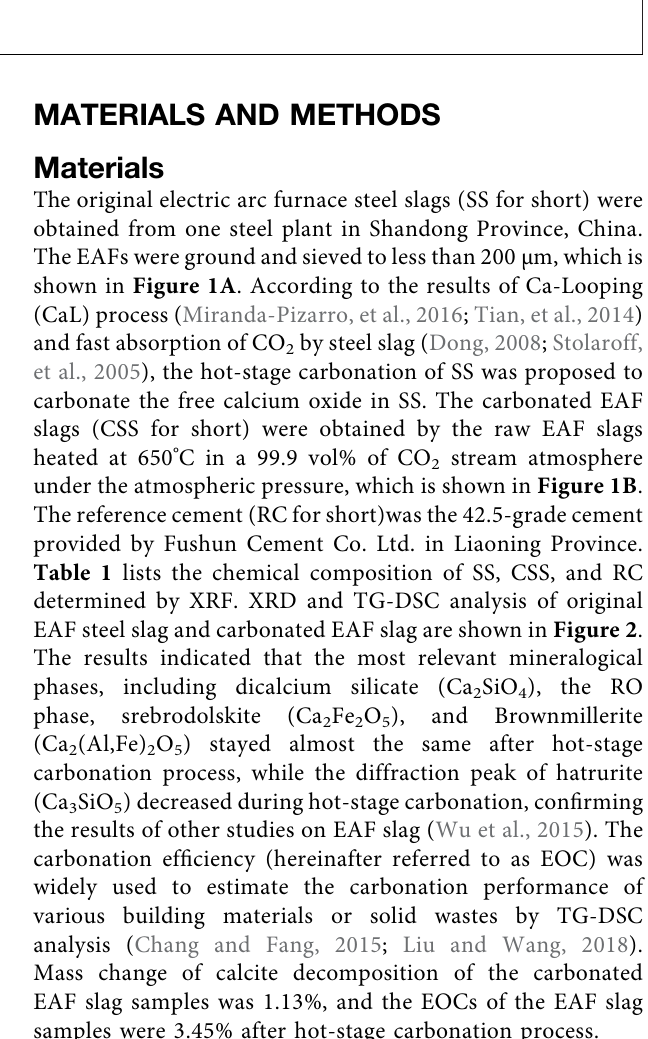
Frontiers in Energy Research |